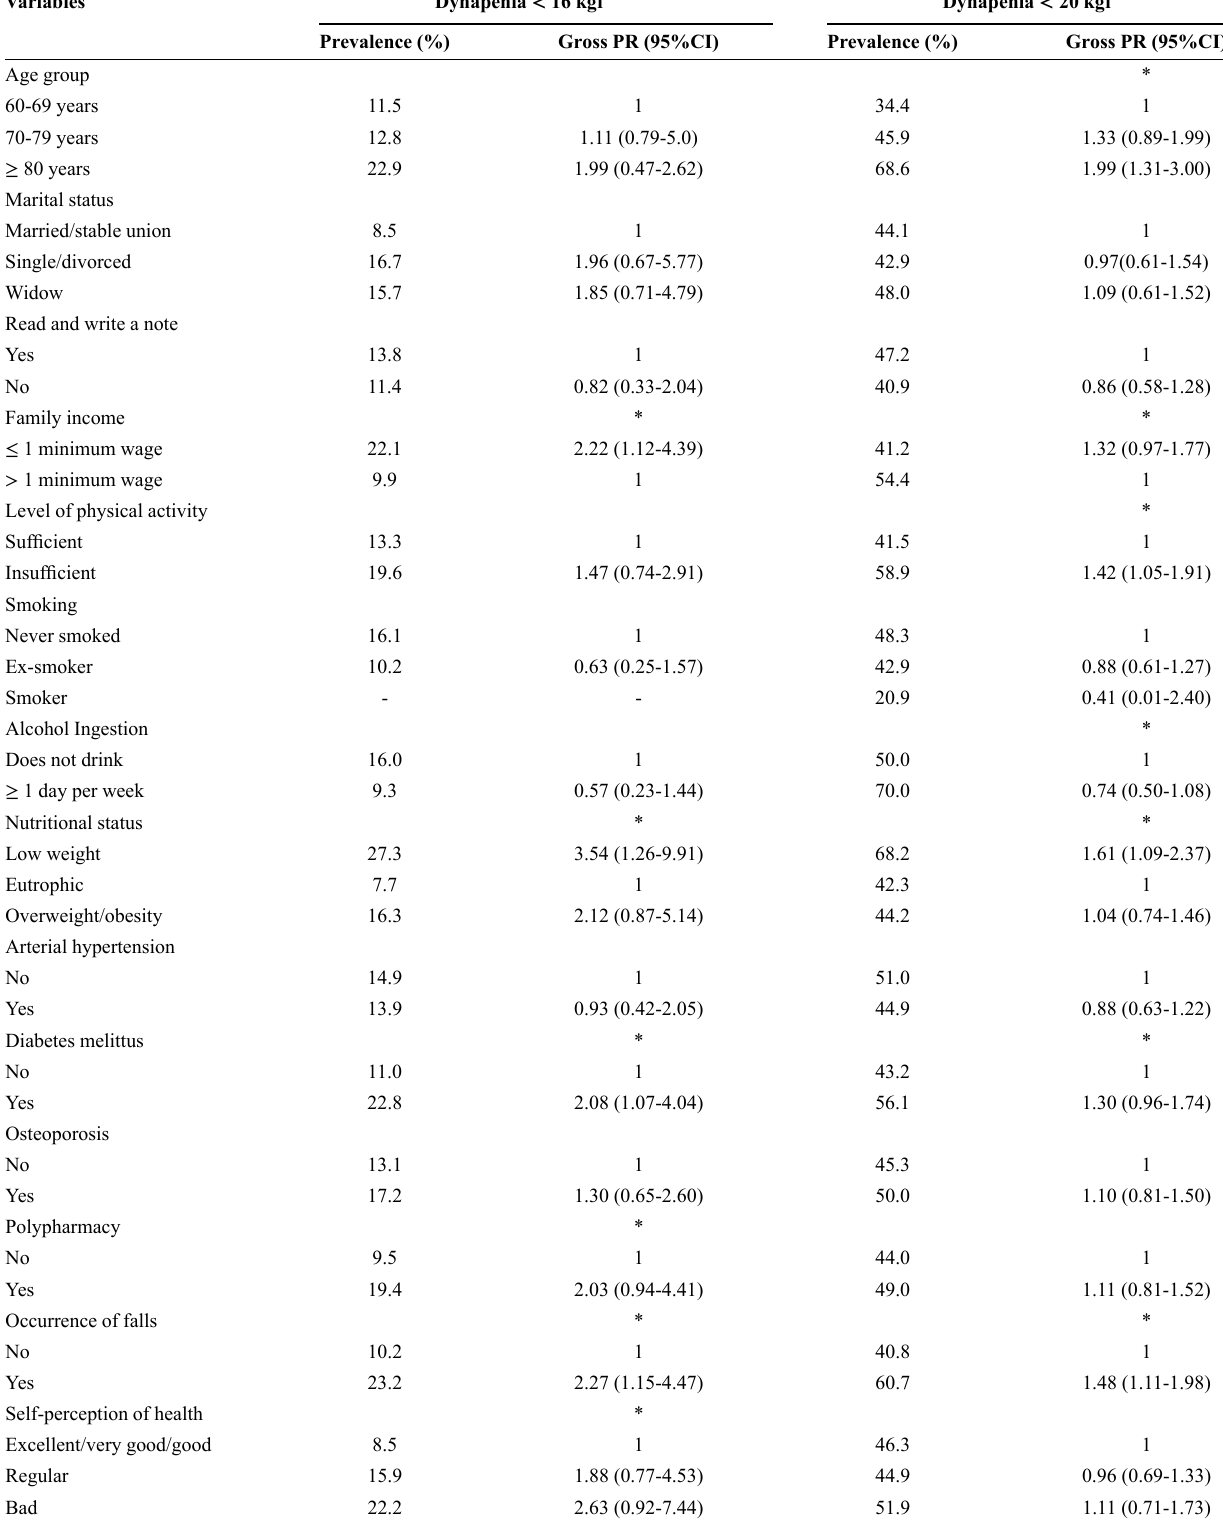
Table 2 - Bivariate analysis between the prevalence of dynapenia by different criteria (HGS < 16 kgf and HGS < 20 kgf) and the independent variables of the study. Jequié-BA, Brazil, 2017.